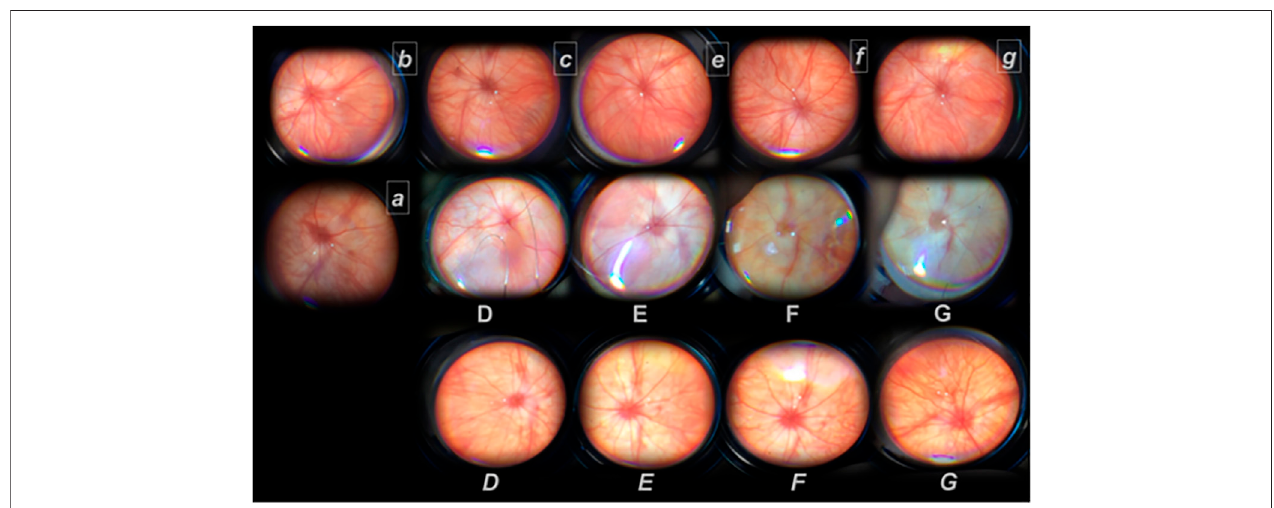
FIGURE4| Presentation oftheretinaafterretrobulbarL-NAMEapplication(withouttherapy(regularfont)andwithBPC157therapy( italicfont ))fromday2(D, D , a, andb )untiltheendoftheexperiment(day3, c ;week1(E, E ,and e );week2(F, F ,and f );week4(G, G,andg )).Ratsreceived.therapyat20 min(allcapitals,D,E,F,andG (saline)or D,E,F,andG ( BPC157 ))orat48 hafterL-NAME(smallletters, a,b,c,d,e,andf ( BPC157 )).Presentationoftheretinaat2 daysafterretrobulbaradministered L-NAME(D, D,a,andb ).D.Salineapplication(at20 min,orat48